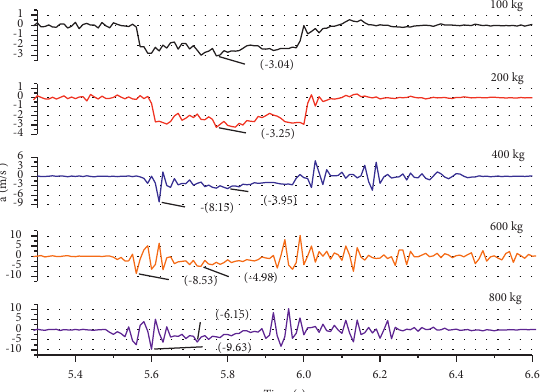
Figure 9: Longitudinal vibrations of the hoist rope during the upward emergency